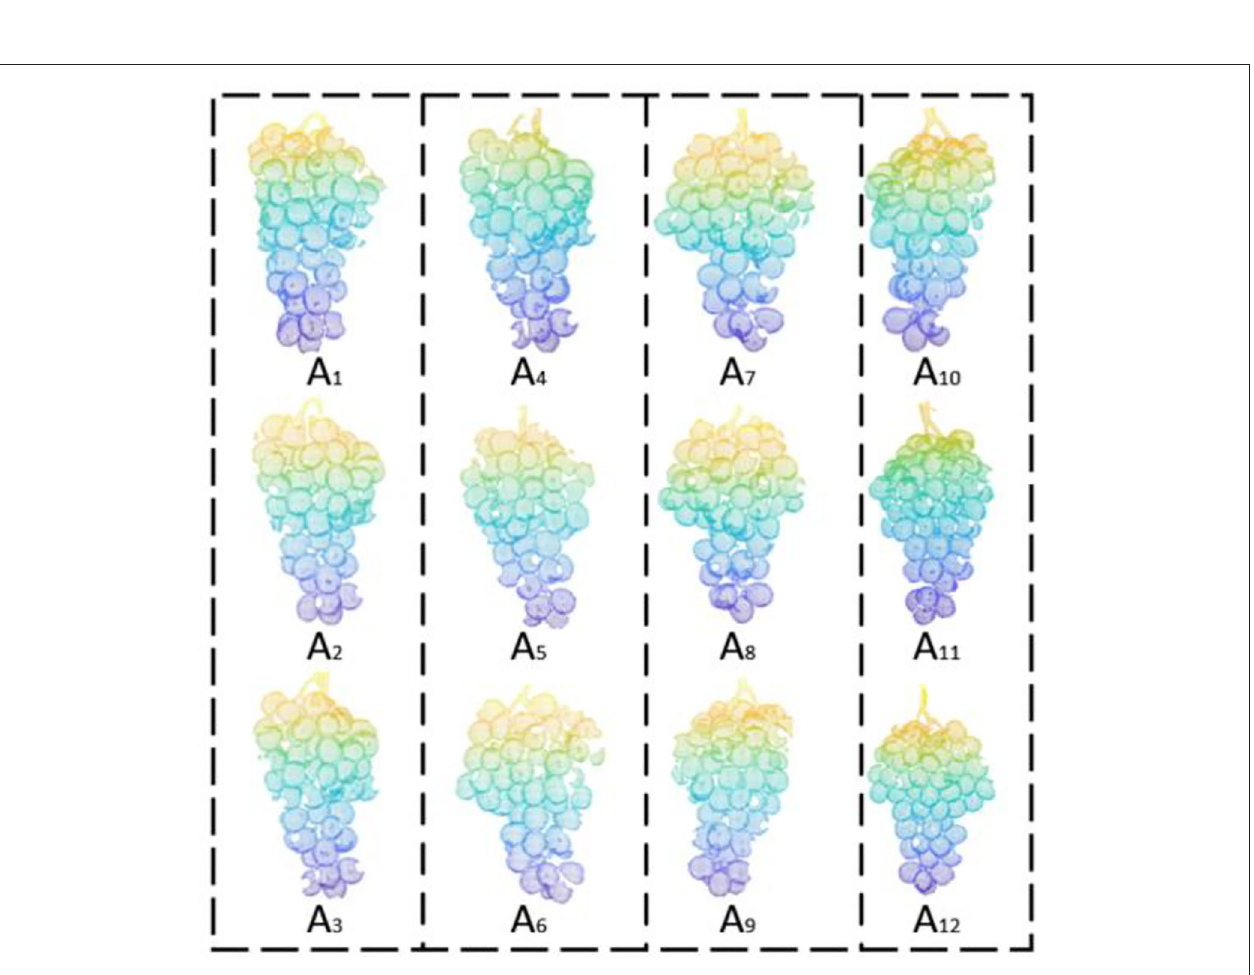
FIGURE 5 | Point cloud renderings of a grape bunch from all